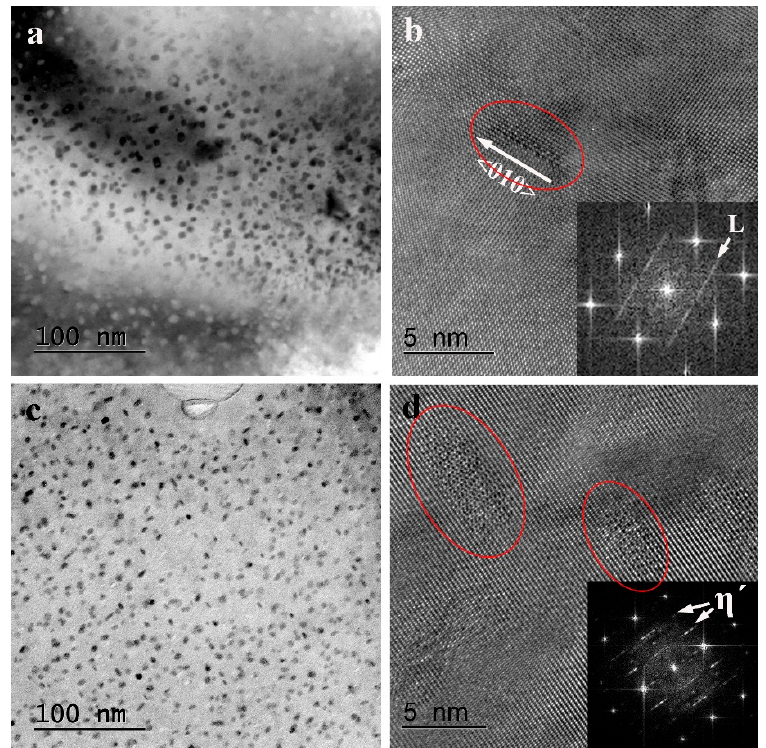
Figure 10. TEM bright-field images of the same area in WNZ after post-aging as the same as Figure 4b along different zone axis: ( a ) along <001> Al zone axis; ( c ) along <112> Al zone axis. High-resolution TEM images and corresponding FFT patterns of different precipitates: ( b ) L precipitate in ( a ) along <001> Al zone axis; ( d ) η ’ precipitate in ( c ) along <112> Al zone axis.